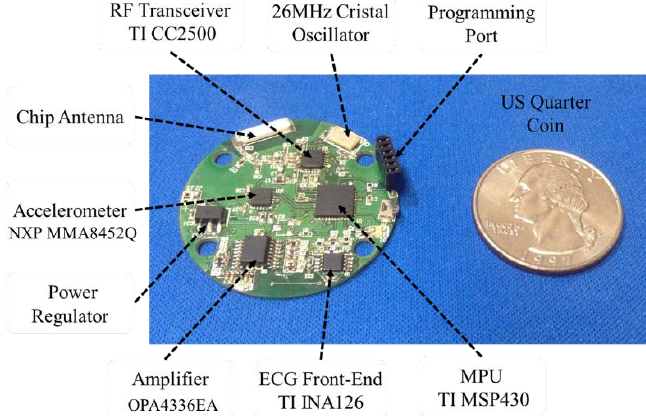
Figure 9. Final optimal prototype of the ECG embedded module.